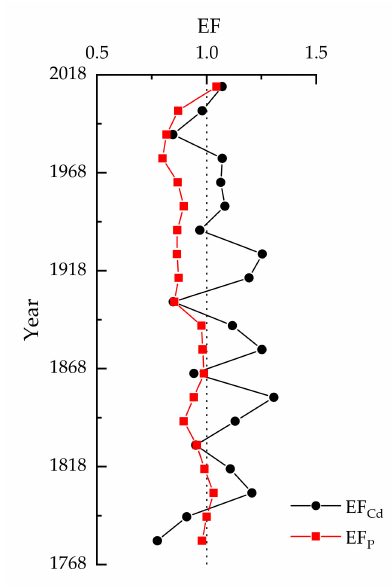
Figure 6. The values of the environmental factor (EF) Cd and EF P changed with